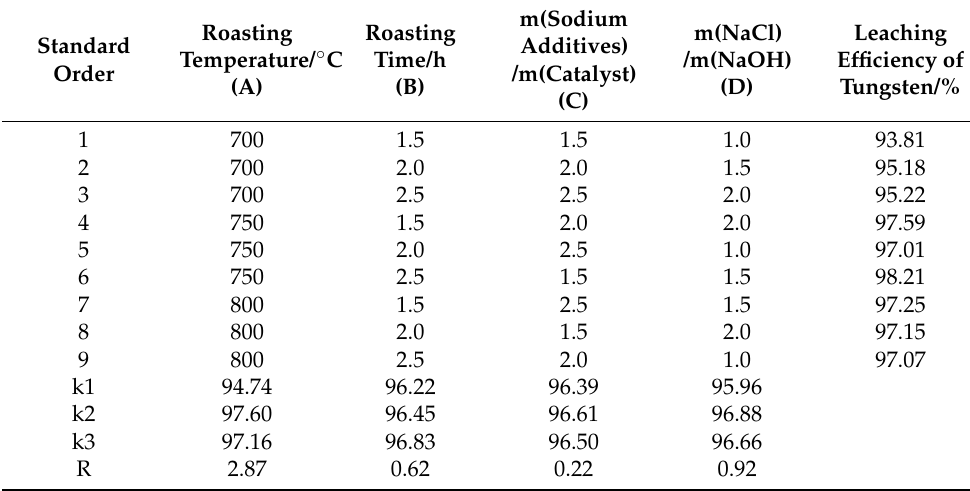
Table 4. Orthogonal experiment design and results of leaching